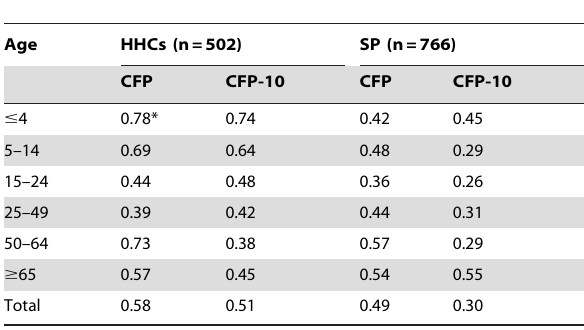
Table 2. Correlation between TST and IFN c production in response to CFP and CFP-10 by age in household contacts (HHCs) and individuals from source population (SP).